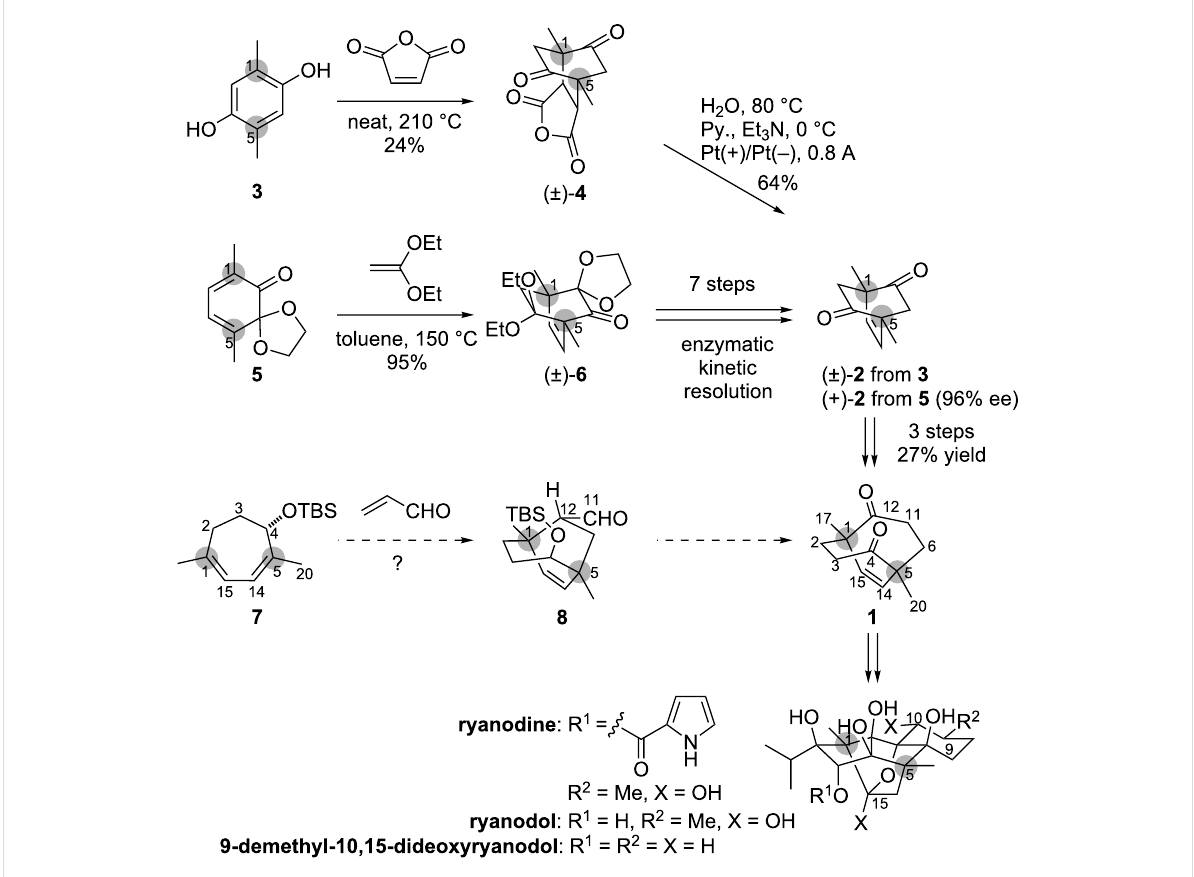
Scheme 1: Structure of ryanodine and the Diels–Alder reactions for construction of the potential intermediates of ryanodine.